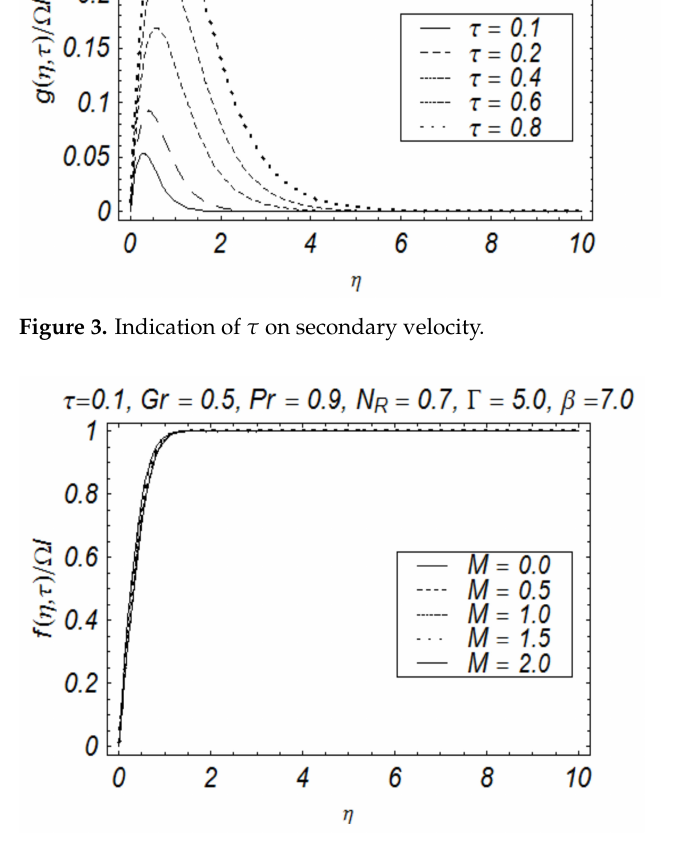
Figure 4. Indication of M on primal velocity.